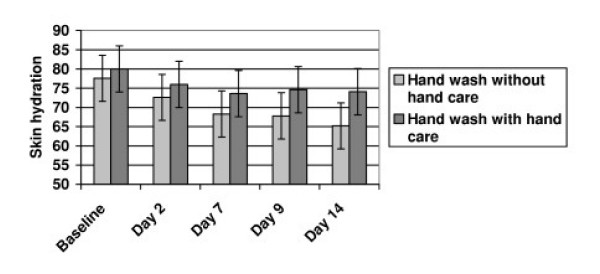
Mean skin hydration (and SD) measured on the forearms over two weeks; hand and forearms were washed daily 4 times for 2 min with a neutral soap, without hand care after the washes (group 1) and with a single application of a hand cream after each wash (group 2).